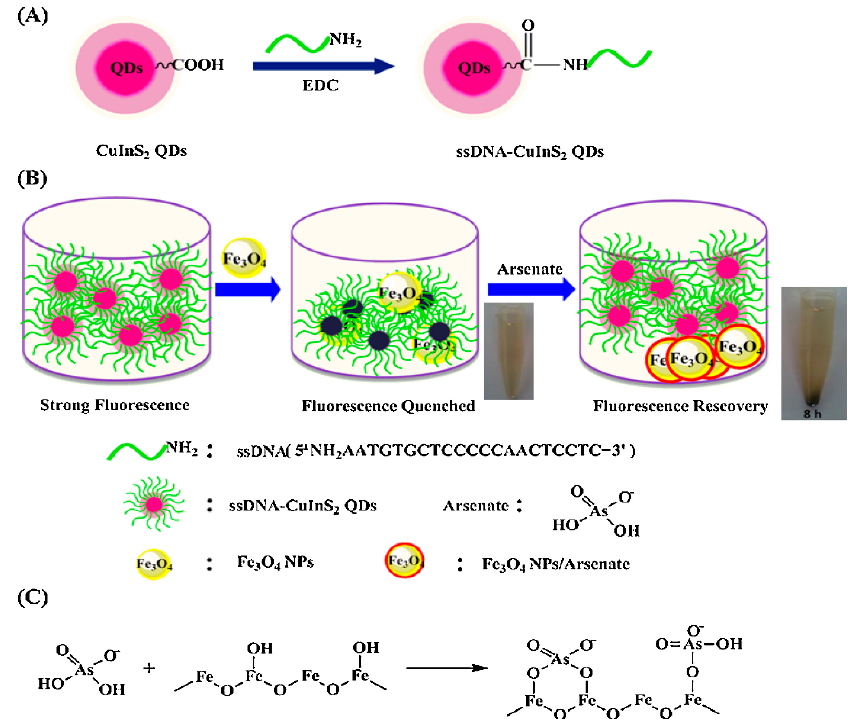
Figure 8. ( A ) Schematic illustration for the fabrication of ssDNA-CuInS 2 QDs. ( B ) The schematic illustration of sensing arsenate by ssDNA-CuInS2 QDs@Fe 3 O 4 NPs and the arsenate removal pho- tographs by a magnet. (C) Schematic illustration of the mechanism of arsenate adsorption onto Fe 3 O 4 NPs [77]. Copyright 2015, reproduced with permission from Elsevier B.V., Amsterdam, The Netherlands.